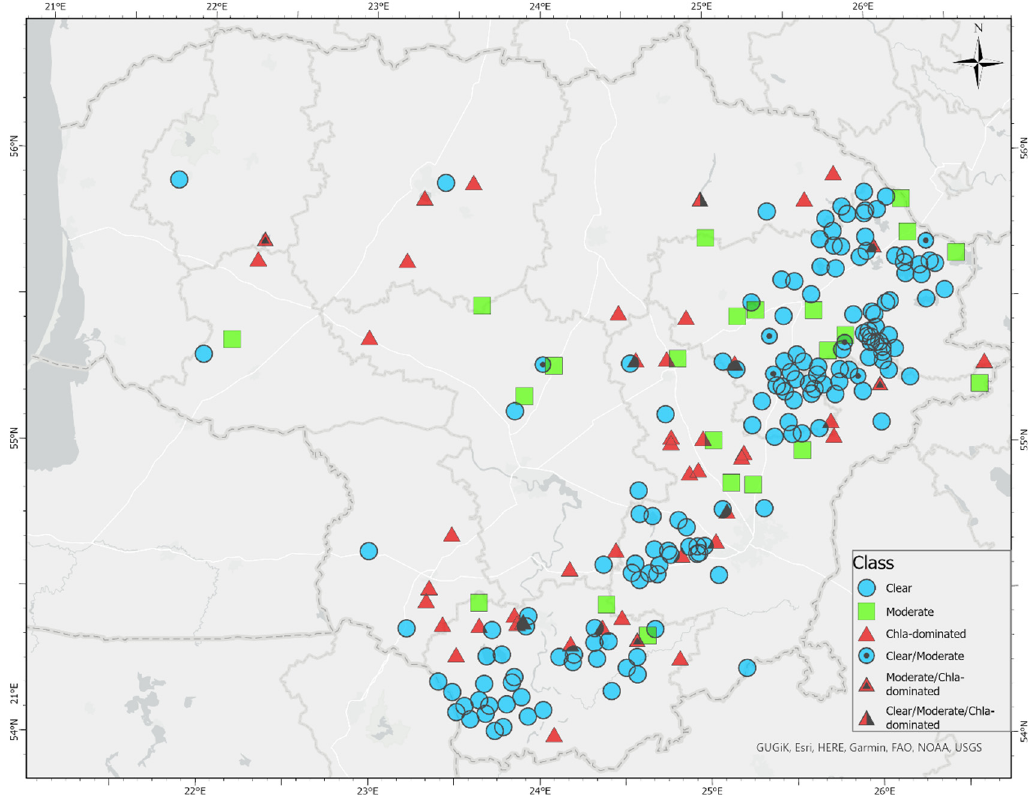
Figure 5. The prevalent class of lakes throughout the 2015–2020 period.